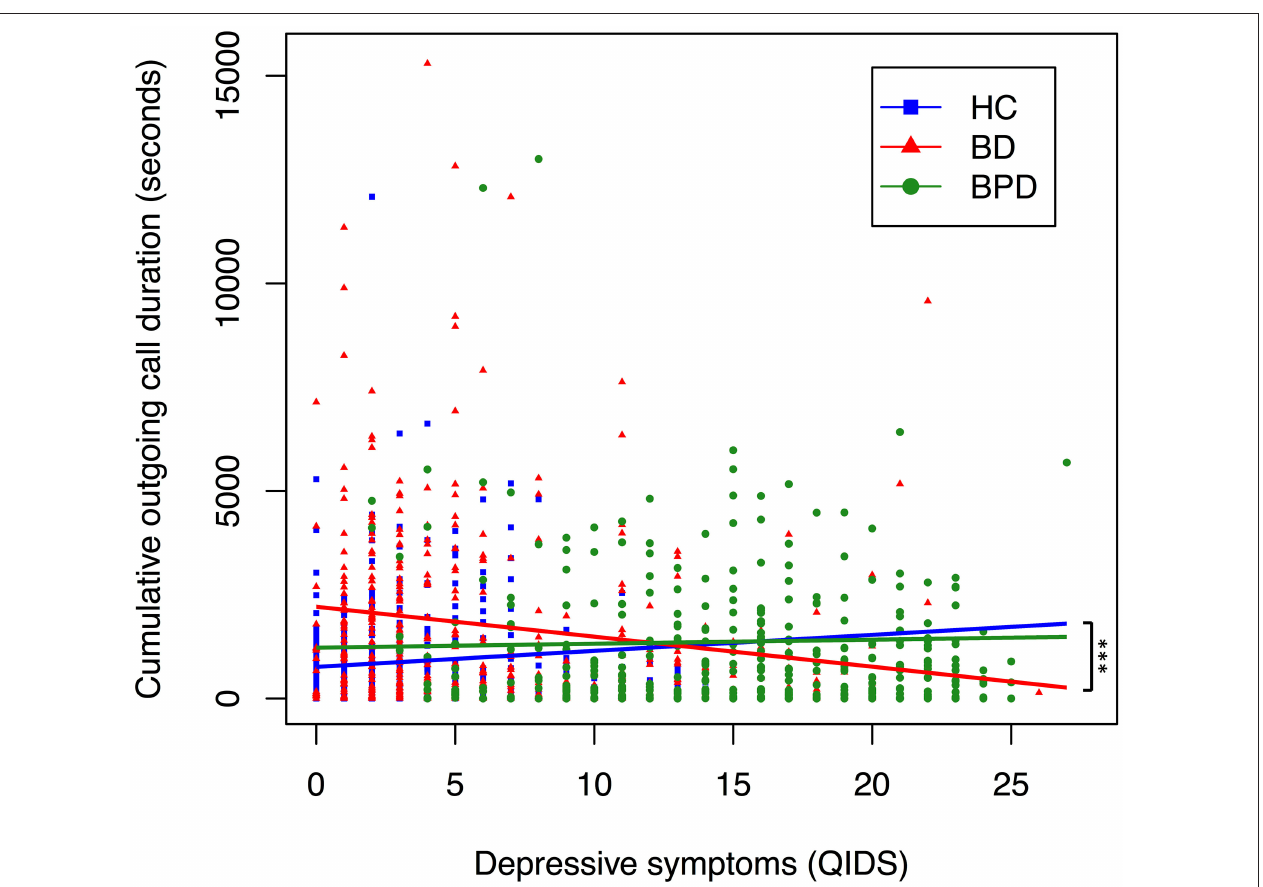
FIGURE 3 | Relationship between depressive symptoms and cumulative outgoing call duration, by diagnostic group. A scatter plot displaying the relationship between depressive symptoms and cumulative total call duration. Each point corresponds to a participants’ depressive symptoms (measured by QIDS) and their cumulative outgoing call duration (measured in seconds) in the 6 days preceding, and day of, a completed mood assessment. Color coding corresponds to diagnosis. Trendline coefficients are taken from linear mixed-effects regression models adjusted for age. Significance testing performed with HC as reference; *** p < 0.001, ** p < 0.01, * p < 0.05. (HC, n = 642; BD, n = 456; BPD, n =